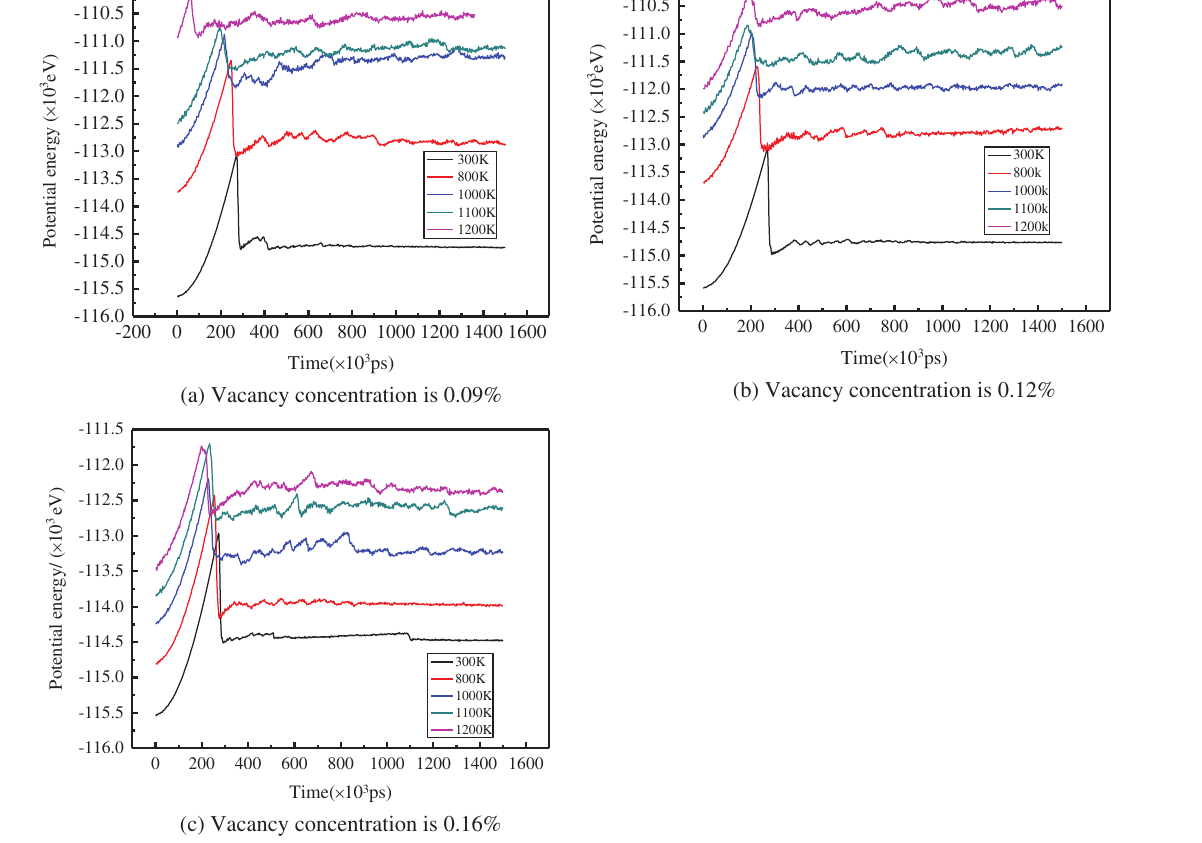
Figure 8: Potential energy curves at different temperatures and vacancy